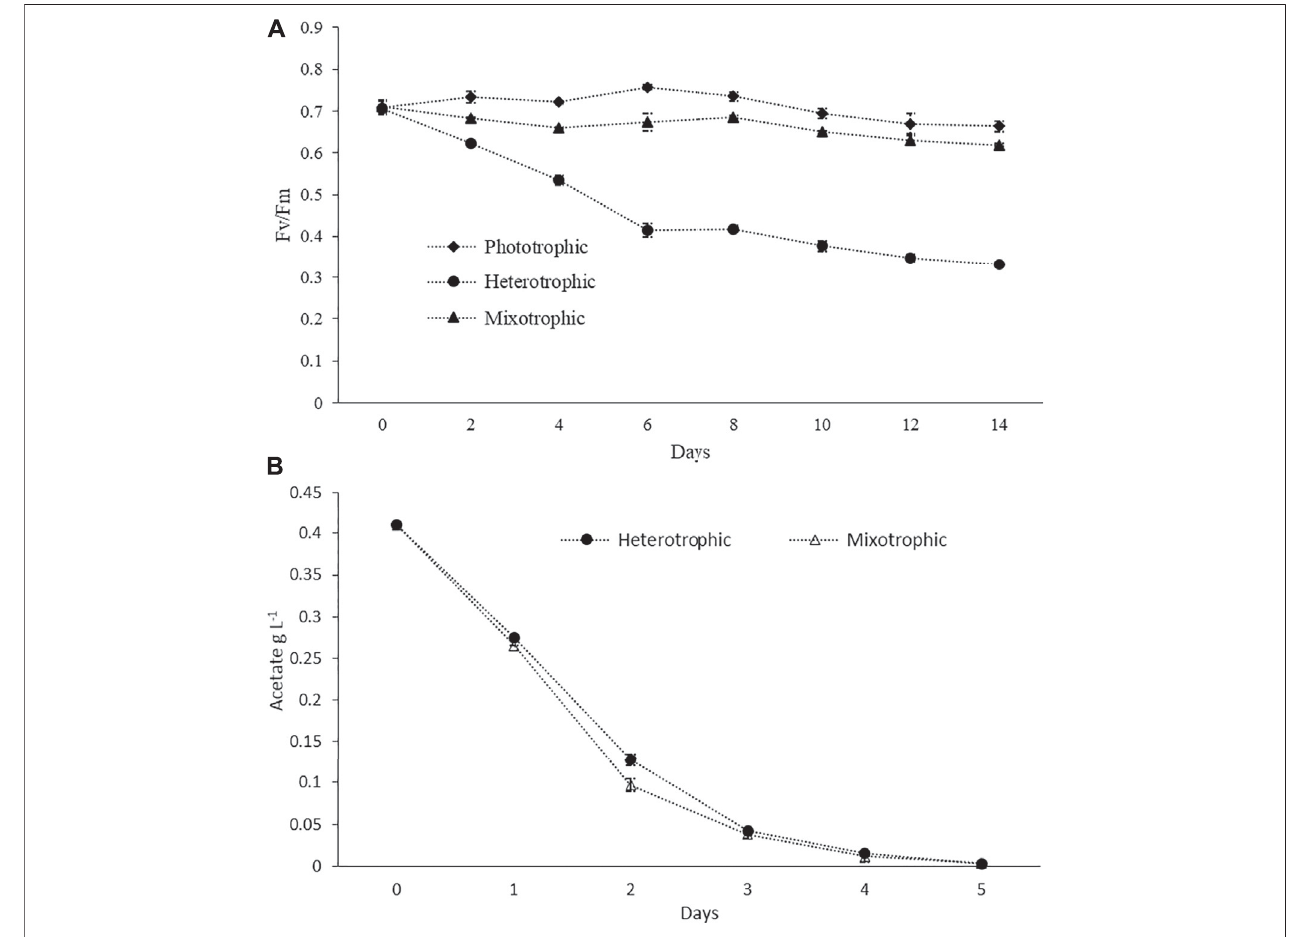
FIGURE 2 | (A) Photosynthetic ef fi ciency measured as PSII quantum yield ( F v / F m ) in phototrophic, heterotrophic, and mixotrophic cultures. (B) Ac consumption pro fi les in the batch mode.